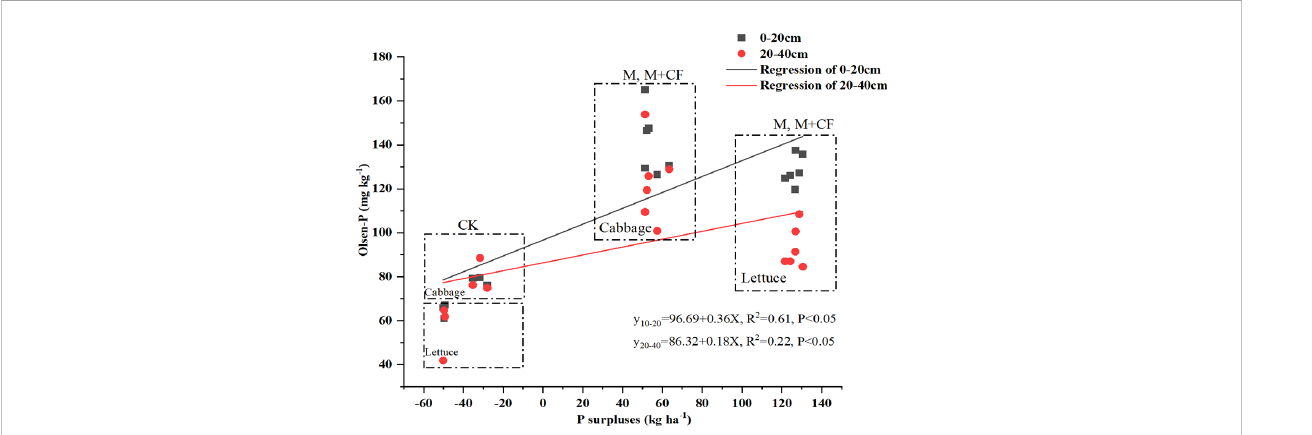
FIGURE 7 Relationships between seasonal P surpluses and available-P (Olsen-P) concentration at two soil layers, per layer for 18 samples of 3 treatments after harvest seasons of the current study. P indicates signi fi cant regressions at < 0.05